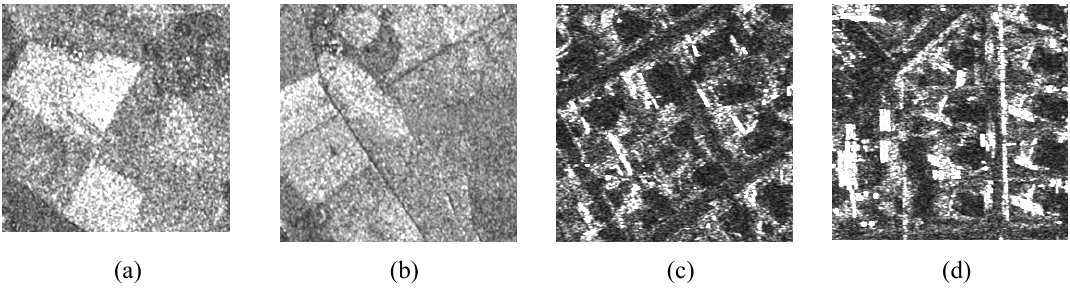
Figure 1. The synthetic aperture radar (SAR) scene images in the same class. ( a ) and ( b ) are the agricultural images, ( c ) and ( d ) are the building images.